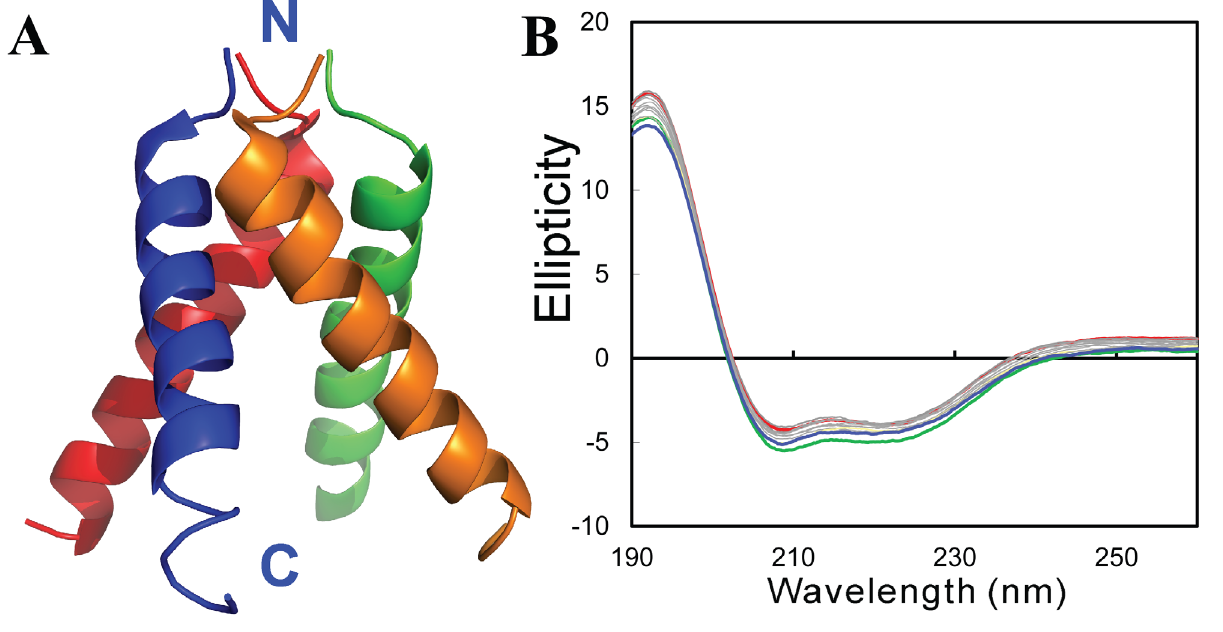
Figure 5. Conformations of the 25-residue integral membrane fragment of the influenza A channel in membrane and unsalted water. ( A ) Tetrameric structure in a membrane environment with the sequence of SSDPL VVAAS IIGIL HLILW ILDRL. ( B ) Far-UV CD spectra of the chemically synthetic peptide solubilized in unsalted water (pH 4.0) at a concentration of 100 µM without any lipid molecules, at 20 ° C (blue), 95 ° C (red) and 20 ° C after the thermal unfolding (green).